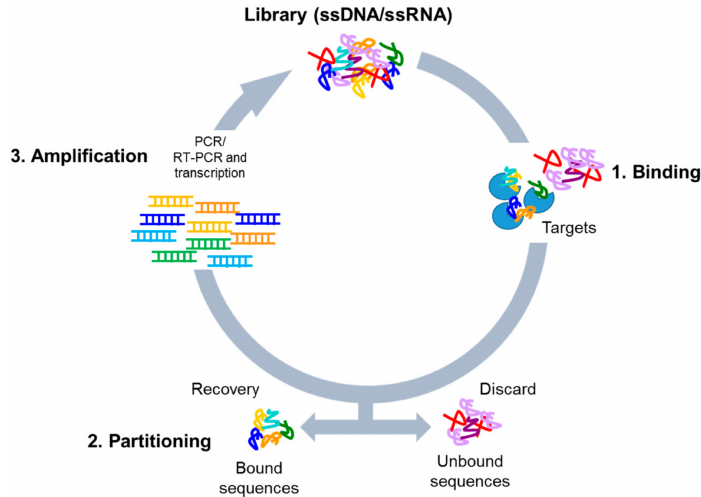
Figure 1. Scheme of the SELEX process. The procedure involves repeated cycles of: 1 . Incubation of the high complexity library with the targets (binding); 2 . Removal of unbound sequences and recovery of the bound oligonucleotides (partitioning); 3 . Amplification of the bound sequences by PCR (for DNA library) or RT-PCR and transcription (for RNA